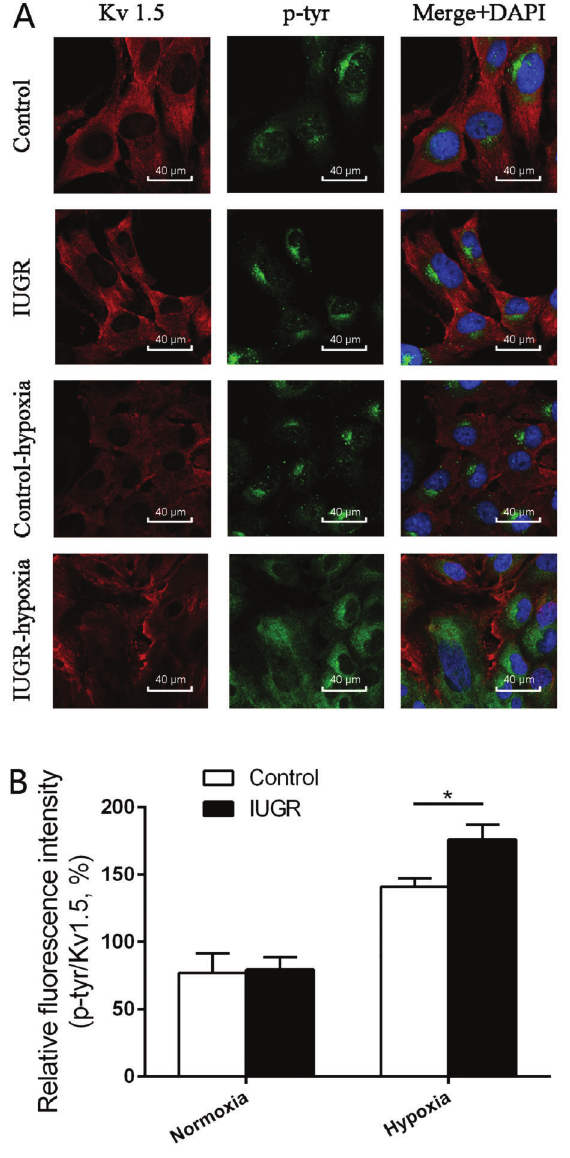
Figure 4. Immuno fl uorescence detection of Kv1.5 and tyrosine- phosphorylated Kv1.5 in pulmonary artery smooth muscle cells PASMCs. A , Kv1.5 expression (red) is downregulated and tyrosine-phosphorylated Kv1.5 expression (green) is upregulated to varying degrees in both intrauterine growth retardation (IUGR) rats and control rats after 2 weeks of hypoxia. Nuclei are stained with DAPI. Scale bar=20 m m. B , Summary histogram of relative fl uorescence intensity of p-tyr/Kv1.5. Data are reported as means ± SD. *P o 0.05